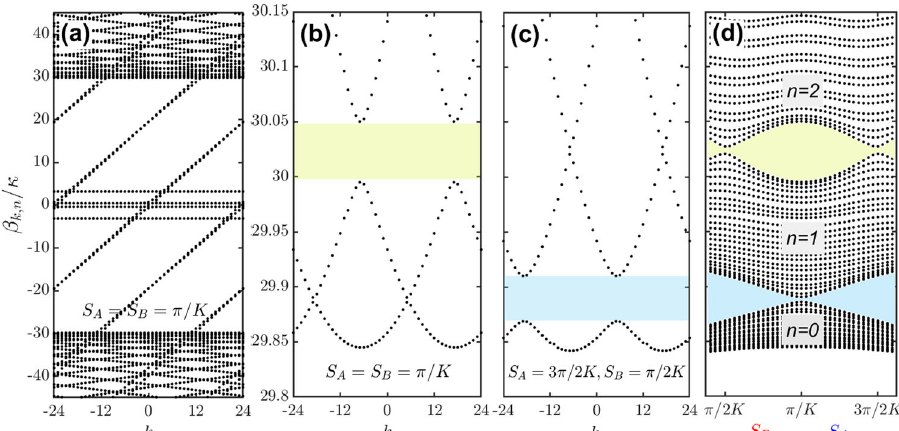
Fig. 2 Phononic band structure in soliton metacrystals. Panels ( a – c ) show the spectrum vs momentum k varying across the two Brillouin zones. The number of Bloch states in one Brillouin zone is K = 24. Panels ( b , c ) zoom on the band structure around the top edge of the continuum, see β k , n / κ ≈ 30 in ( a ) Panel ( d ) demonstrates how the band structure changes with the inter-soliton distance S α . The blue and yellow shading in ( b – d ) highlight the fi rst and second bandgaps.